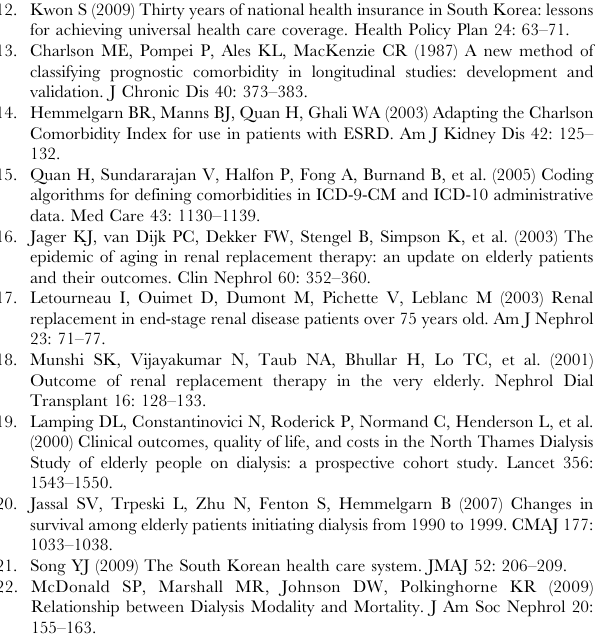
Figure 2. Comparision of hazard ratios of all independent predictors for mortality in the multivariate Cox analysis according to the age categories. Age, peripheral vascular disease, and hemiparesis were the factors by which mortality risk gradually increased with increasing age groups. However, the influences of Medical Aid, peritoneal dialysis, diabetes mellitus, congestive heart failure, liver disease, and any malignancy on the mortality sequentially decreased with aging. * Mortality rates between patients on hemodialysis and those on peritoneal dialysis were compared in the intention-to-treat analysis. HR, hazard ratio; CI, confidence interval.